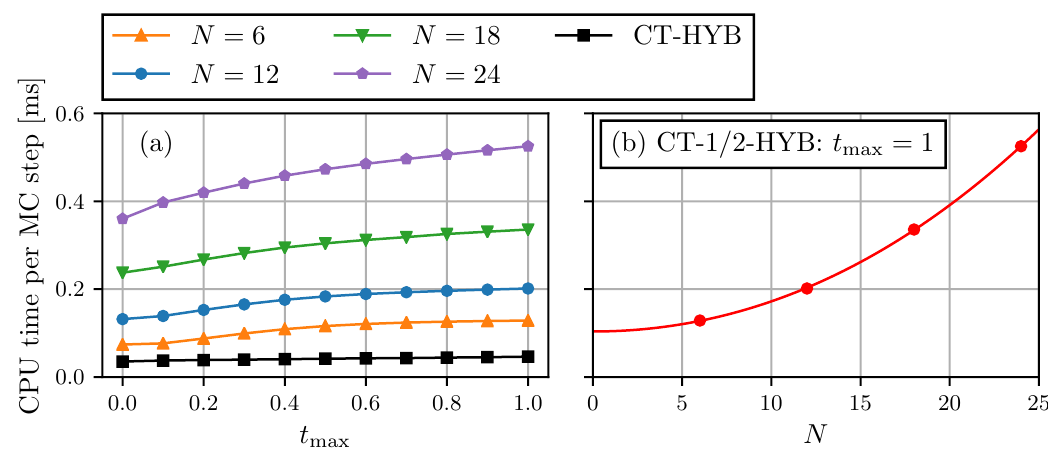
Figure 8: (a) CPU time per Monte Carlo step for CT-HYB and CT-1 / 2-HYB for several values of N as a function of t . (b) CPU time per step for CT-1 / 2-HYB as a function max = 1 and a fit of the form f ( N ) = c + aN 2 + bN of N for t max